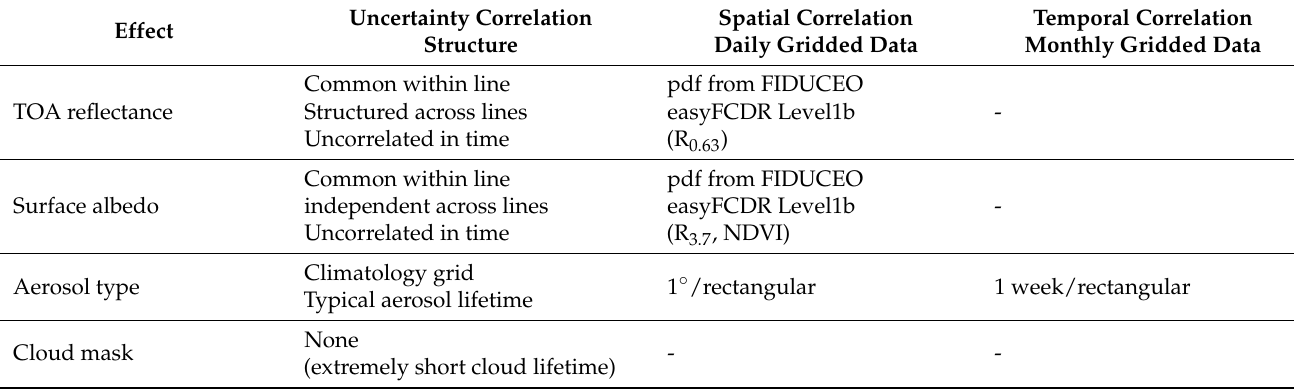
Table 7. Averaging the different effects to super-pixels and gridded products.